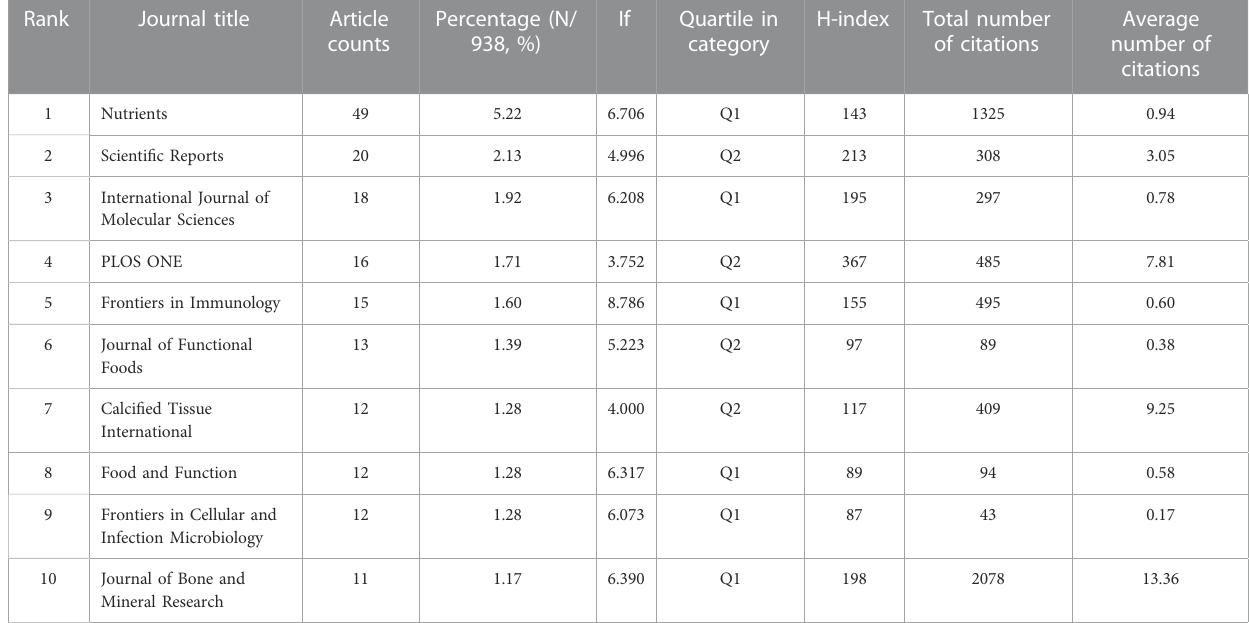
TABLE 2 The top 10 most active journals with the highest number of published